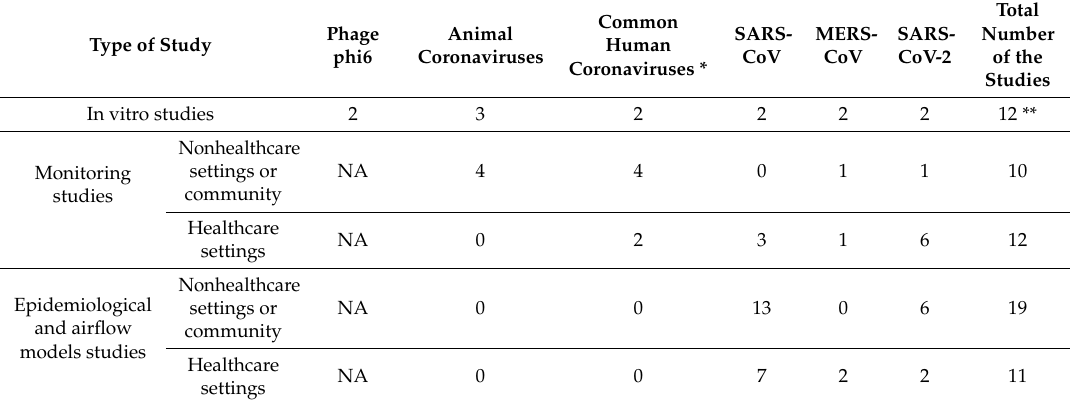
Figure 2. Distribution of the collected paper: ( a ) topic distribution; ( b ) time trend and topic. Table 1. Number of reviewed papers according to the topic and the type of coronavirus or surrogate.